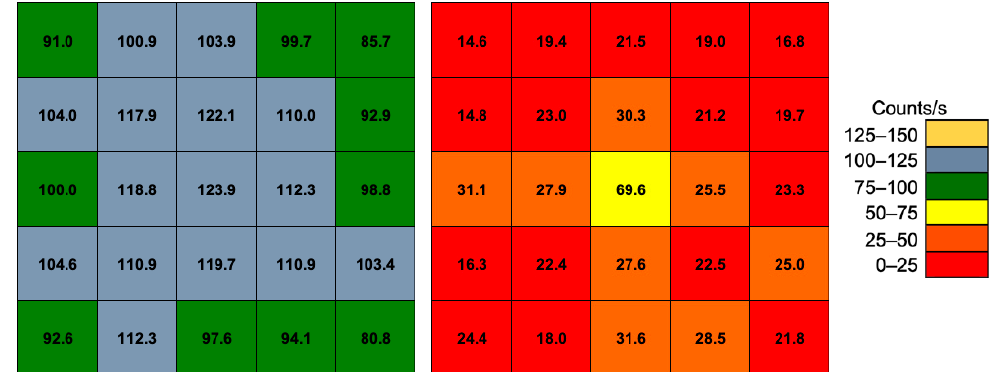
Figure 11. Overall count rates of the 5 × 5 array above a threshold of 30 keV. Left: without the collimator; right: with the collimator.